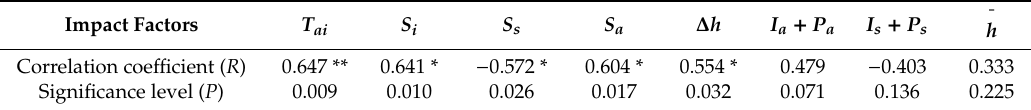
Table 3. Correlation between the soil-ground water storage utilization and the eight impact